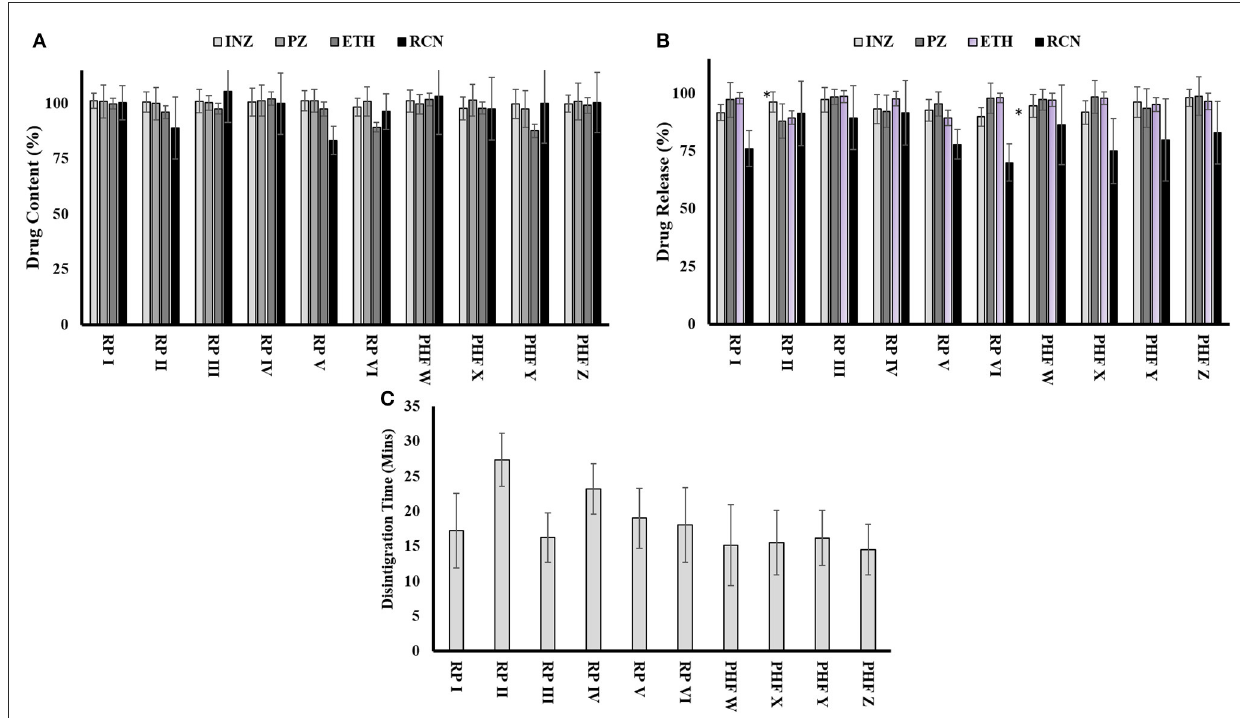
FIGURE4 Quality attributes of FDCs samples collected from various places: (A) evaluation of content uniformity of drugs in 4-FDCs, (B) dissolution profile of drugs from 4-FDCs, and (C) disintegration time of 4-FDCs. * RP, retail pharmacy; PHF, public health facility; INZ, isoniazid; PZ, pyrazinamide; ETH, ethambutol; RCN,